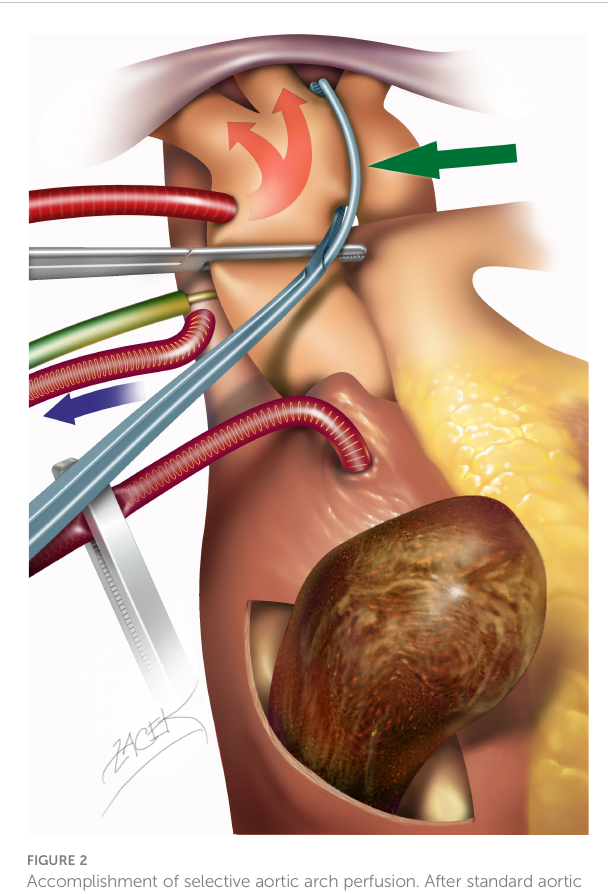
FIGURE 2 Accomplishment of selective aortic arch perfusion. After standard aortic cannulation and cross-clamping, a second curved aortic clamp (green arrow) is applied obliquely beyond the origin of the left carotid artery. In this manner, the aortic cannula perfuses during deep hypothermic circulatory arrest, predominantly the head arteries, at a reduced rate and under near infrared spectroscopy NIRS cerebral oximetry